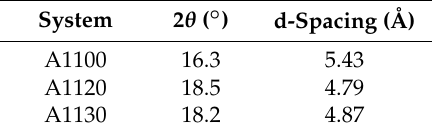
Table 2. Chain spacing of the cross-linked epoxy resins doped nano silica particles grafted with three different chain lengths of aminosilane coupling